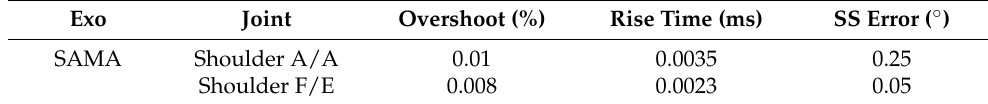
Table 7. Experimental dynamic responses of SAMA